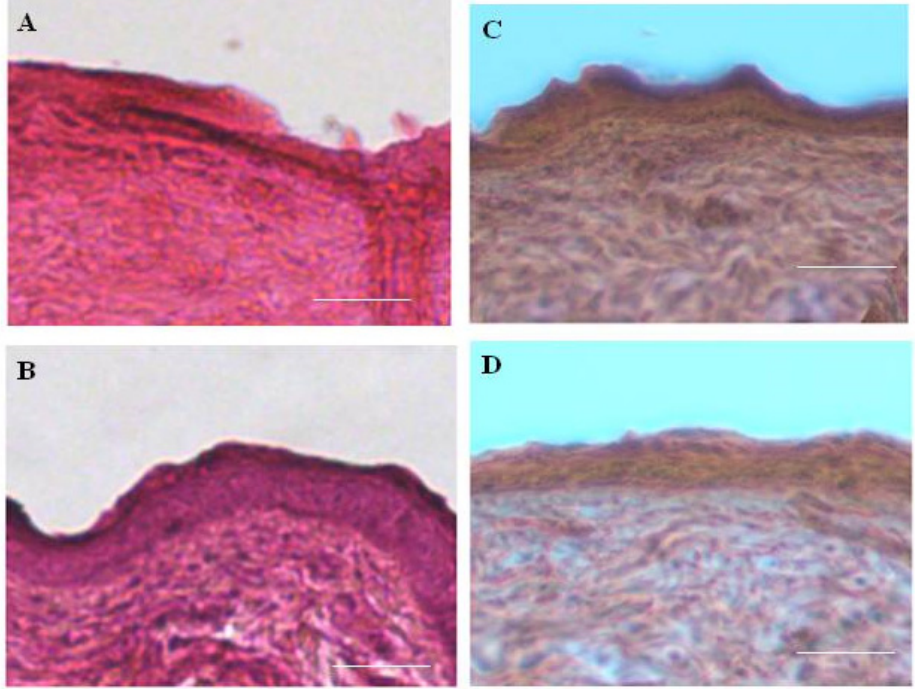
Figure 6. Images of histological sections of rat skin in the area of complete wound healing (A = 100%), stained with hematoxylin-eosin, magnification ×100, scale: 100 μ m. ( A ): native rat skin (normal); ( B ): group 1 on the 40th day of the experiment; ( C ): group 2 on the 23rd day of the experiment; ( D ): group 3 on the 23rd day of the experiment.